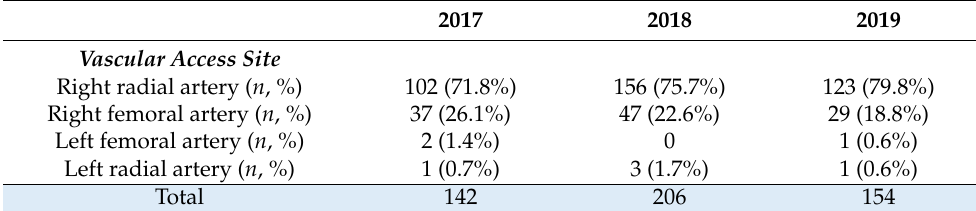
Table 4. Vascular access site by year.